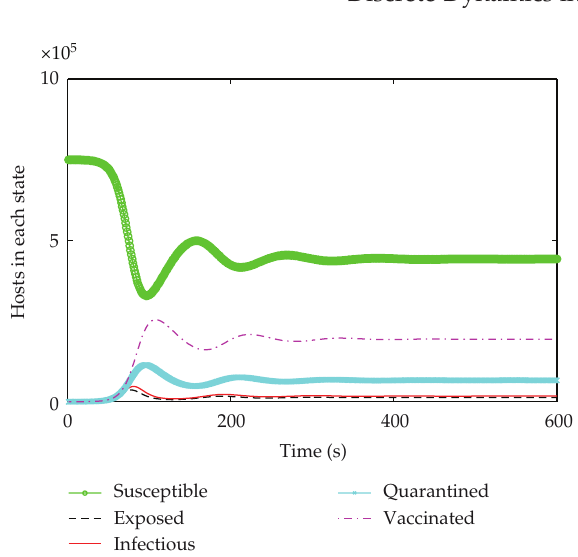
Figure 2: Propagation trend of the five kinds of host when τ < τ 0